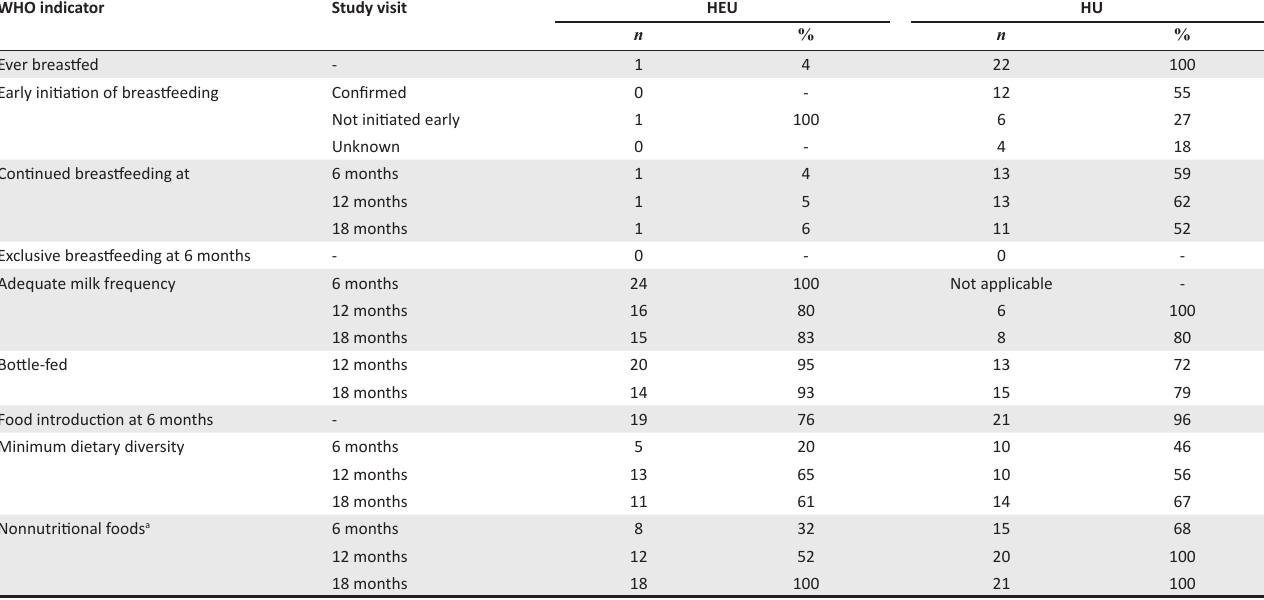
TABLE 2: Feeding practices by World Health Organization indicators 19 of HIV-exposed uninfected and HIV-unexposed children. WHO indicator Study